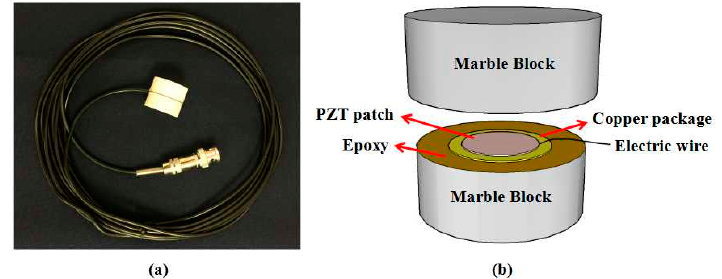
Figure 1. Photo of a smart aggregate (SA) ( a ) and the schematic of a smart aggregate ( b ).